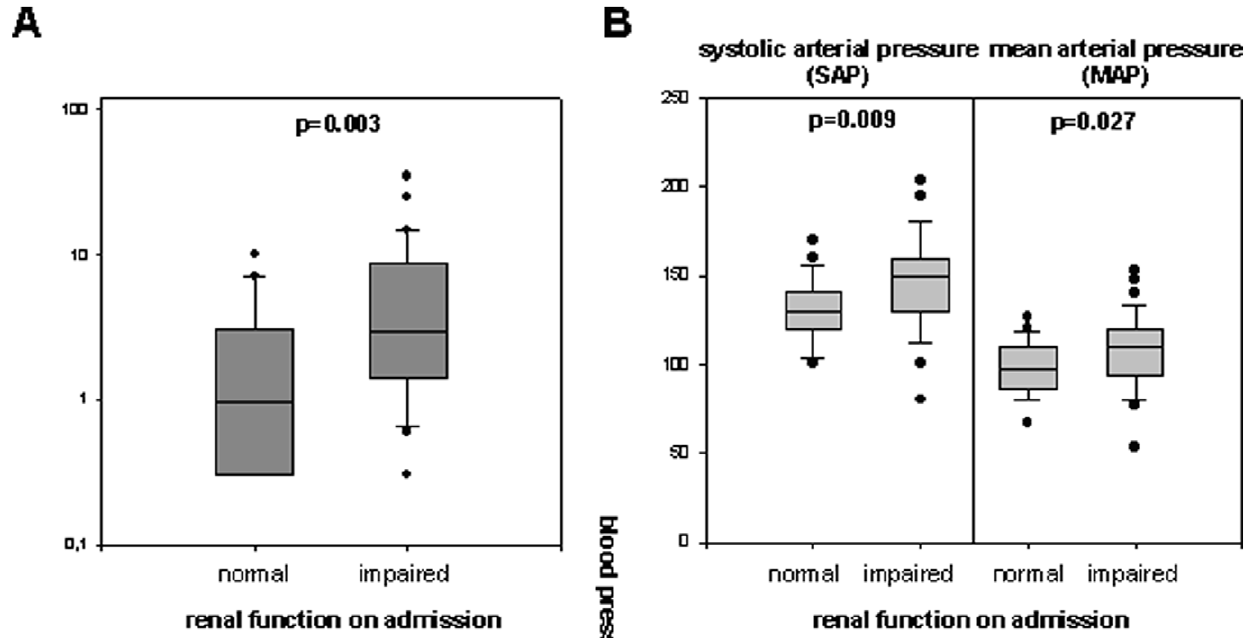
Figure 1. Risk factors for renal insufficiency in TMA. A: CRP serum levels on admission are significantly higher in patients with renal insufficiency compared to patients with normal renal function. B: Systolic arterial pressure (SAP) and mean arterial pressure (MAP) on admission are significantly higher in TMA patients with renal insufficiency.